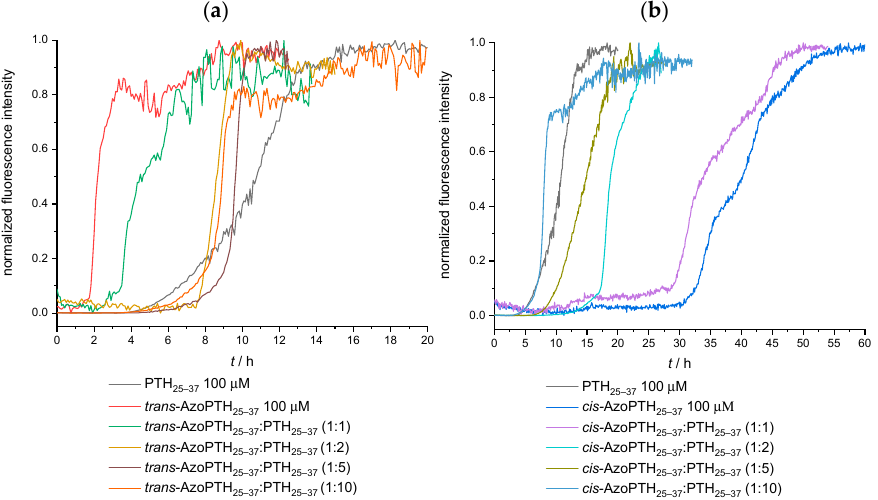
Figure 6. ( a ) ThT-monitored fibrillization assay of PTH 25–37 and mixtures with trans -AzoPTH 25–37 (average of triplets; T = 37 °C, buffer = 50 mM Na 2 HPO 4, pH = 7.4): (black) PTH 25–37 (100 μ M), (red) trans- AzoPTH 25–37 (100 μ M), (green) trans- AzoPTH 25–37 :PTH 25–37 (100 μ M:100 μ M), (dark yellow) trans- AzoPTH 25–37 :PTH 25–37 (50 μ M:100 μ M), (brown) trans- AzoPTH 25–37 :PTH 25–37 (20 μ M:100 μ M), and (orange) trans- AzoPTH 25–37 :PTH 25–37 (10 μ M:100 μ M) ( b ) ThT-monitored fibrillization assay of